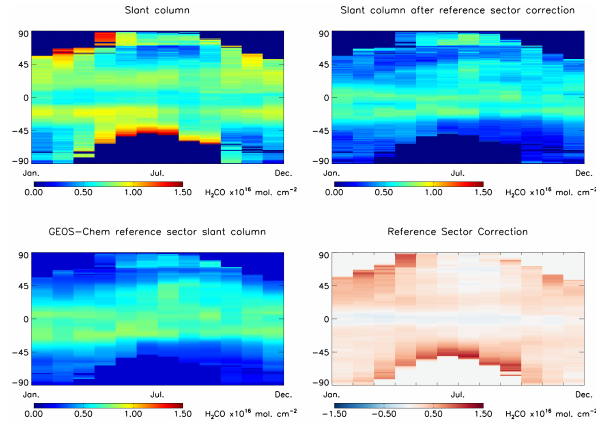
Figure 6. August 2007 GEOS-Chem monthly mean climatology used in the calculation of the reference sector background concen- trations. The portion of the remote Pacific Ocean used is enclosed by the two black vertical lines. The region above Hawaii has been excluded from the longitudinally averaged concentrations. Note the logarithmic scale used for the colorbar. Overplotted are the five re- gions used in the time series shown in Fig. 9 as described in the text.